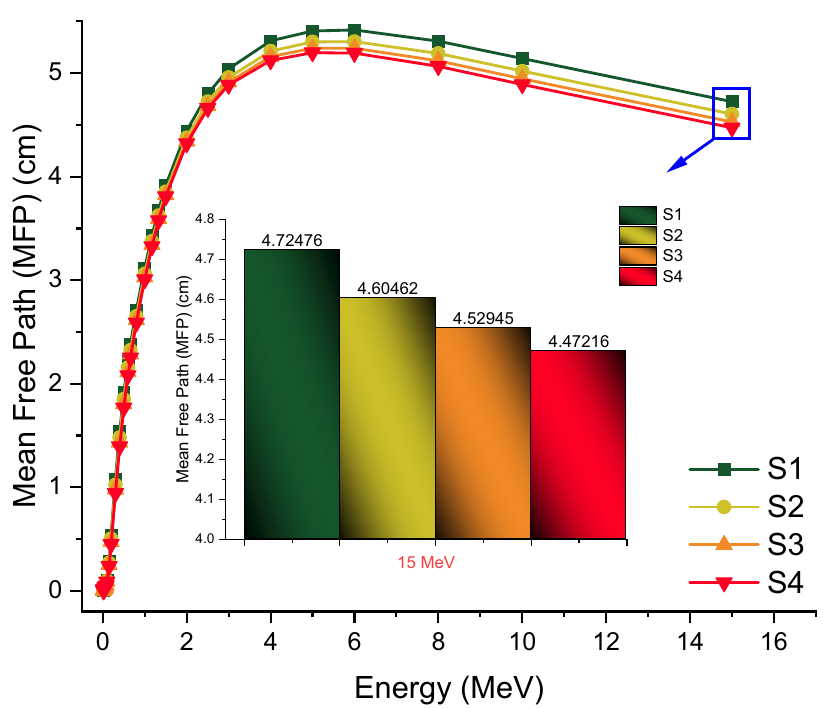
Figure 6: Variation in mfp ( cm ) with photon energy ( MeV ) for all S1 – S4